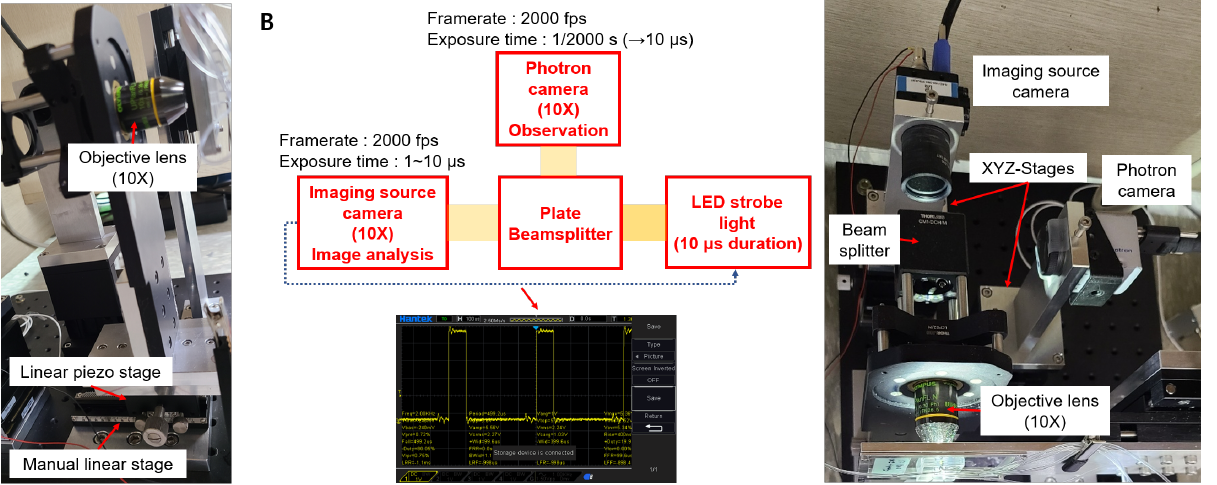
Figure 4. ( A ) High-resolution linear piezo-stage to obtain in-focus images of the flowing cells, ( B ) LED strobe light to minimize the motion blur issue of the fast-flowing